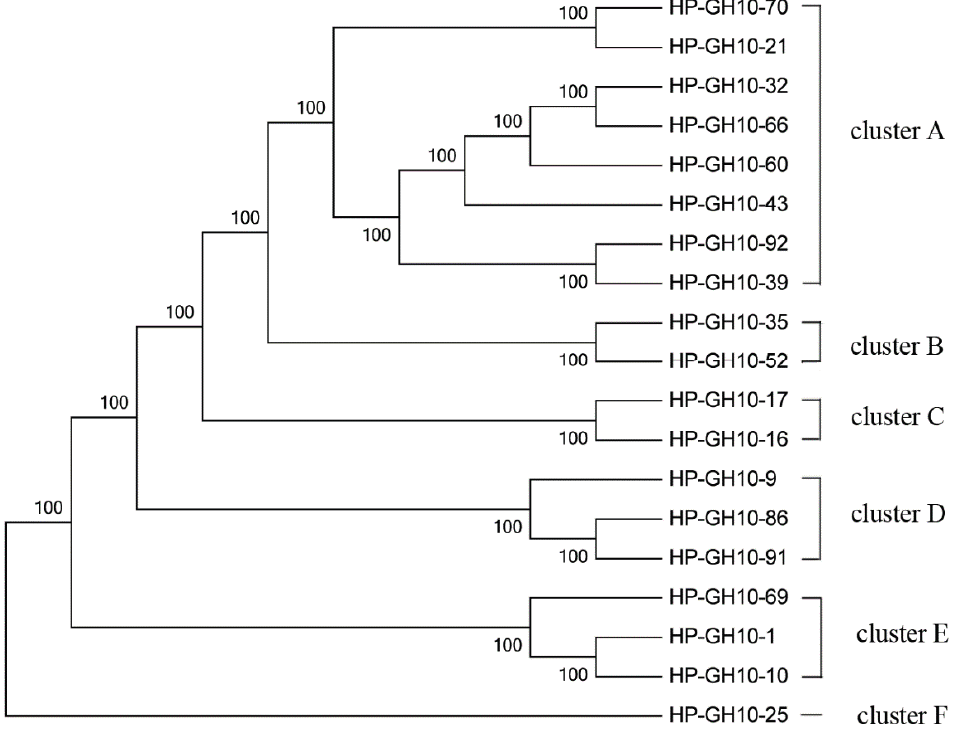
Figure 6. Maximum Likelihood phylogenetic tree of the GH10 amino acid